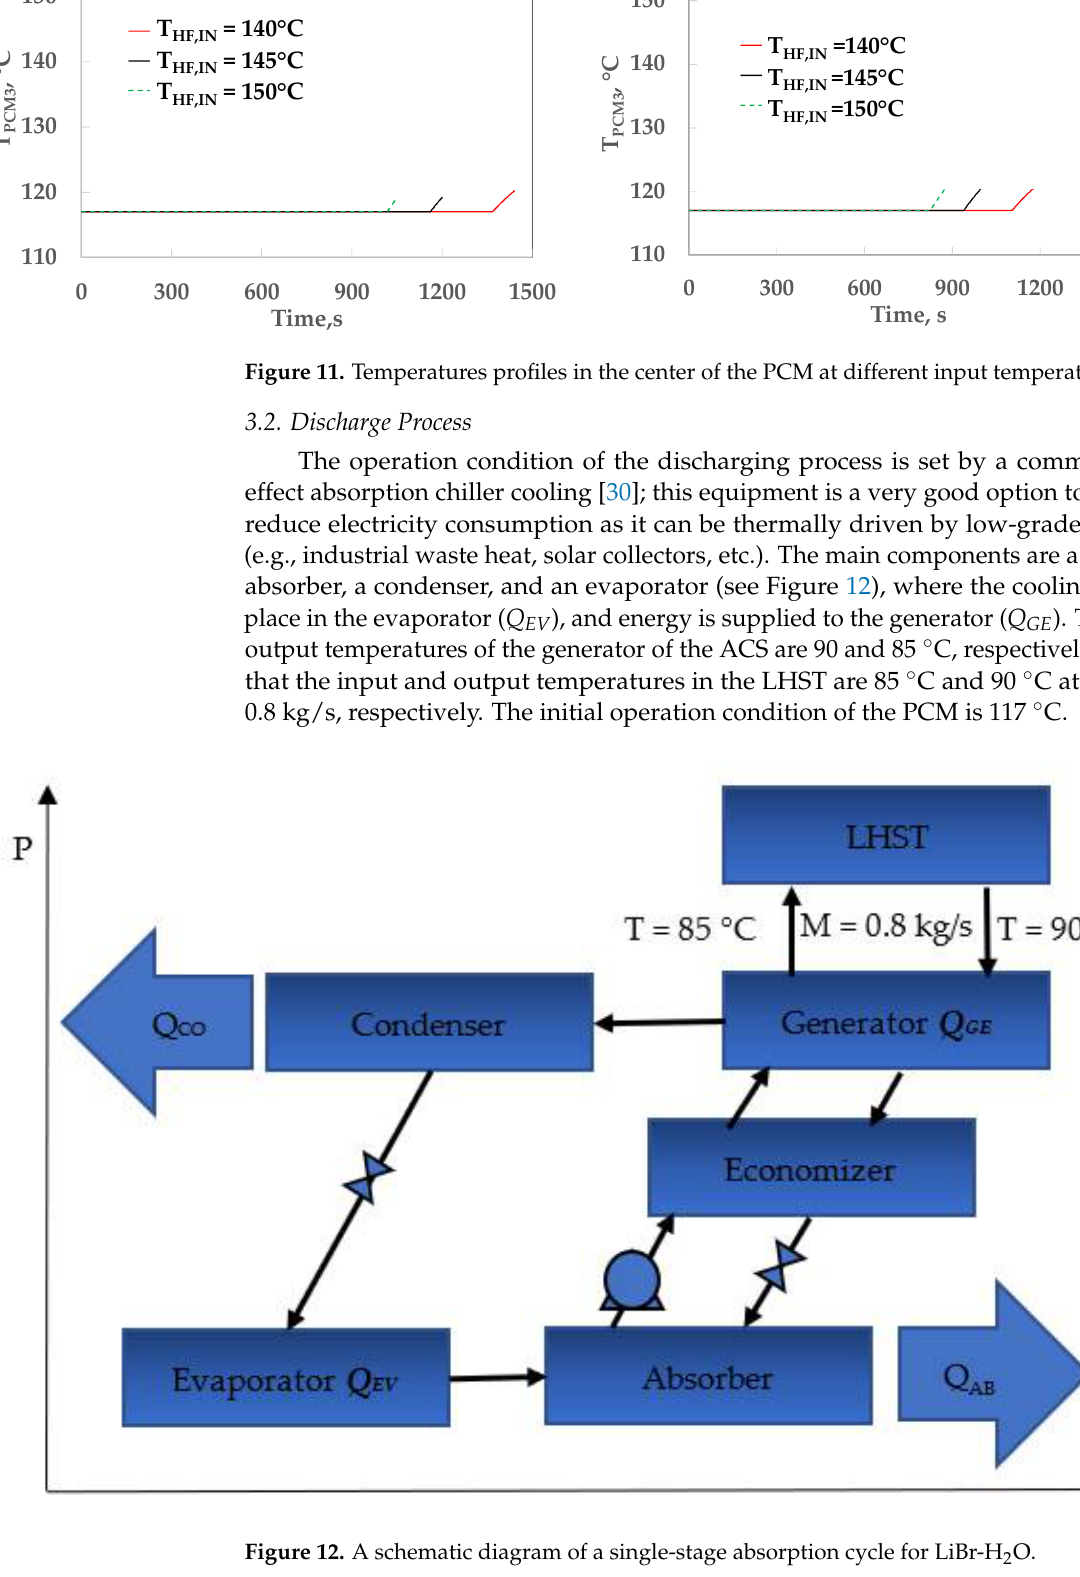
Figure 12. A schematic diagram of a single-stage absorption cycle for LiBr-H 2 O.